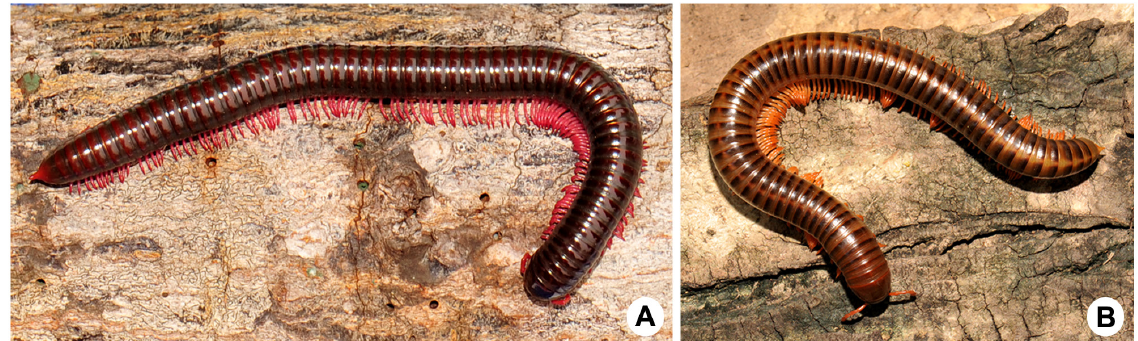
Fig. 11. A . Thyropygus navychula sp. nov., specimen from Surin Islands, living ♂ (paratype, CUMZ-D00089-1). B . Thyropygus forceps sp. nov., specimen from Namwang Srithammasokrach, living ♂ (paratype,